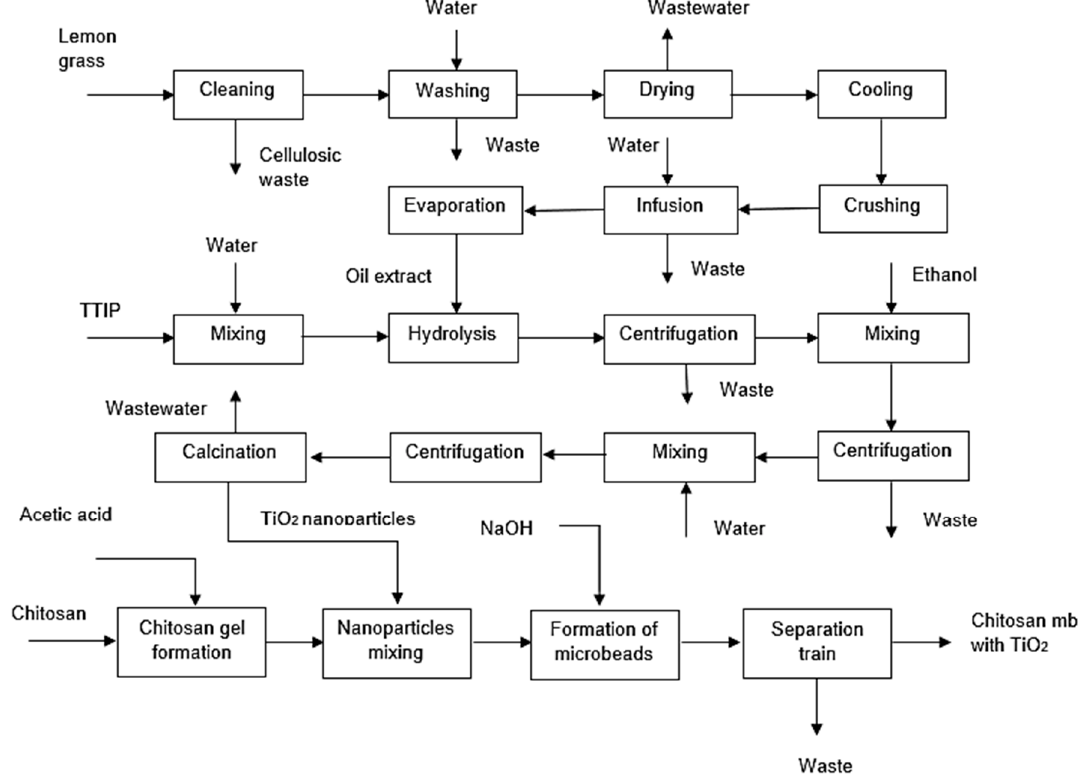
Figure 1. Process diagram of large-scale production of chitosan microbeads modified with TiO 2 nanoparticles .